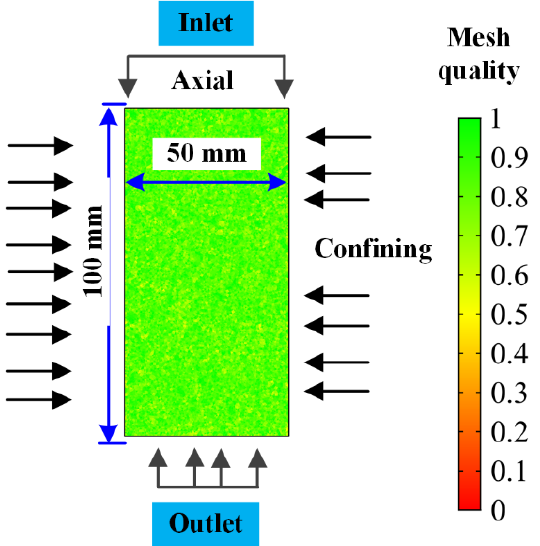
Figure 3. Numerical calculation model of triaxial compression.